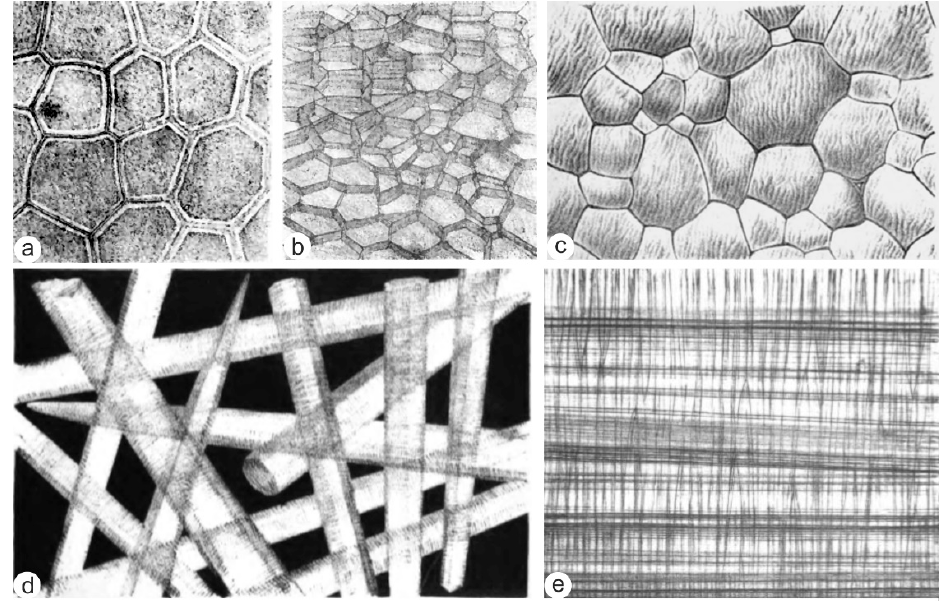
Figure 1. Historical illustrations of the structure of the prismatic layer of Pinna . ( a ) Transverse section showing the inter-prismatic organic membranes. ( b ) Decalcified transverse section showing the inter-prismatic organic membranes. ( c ) Outer surface of the prismatic layer showing oblique crests. ( d ) Isolated prisms showing the polygonal sections and faint growth lines. ( e ) Longitudinal sections showing the synchronic growth lines across adjacent prisms. ( a , b ) from Bowerbank [5], ( c – e ) from Carpenter [6].